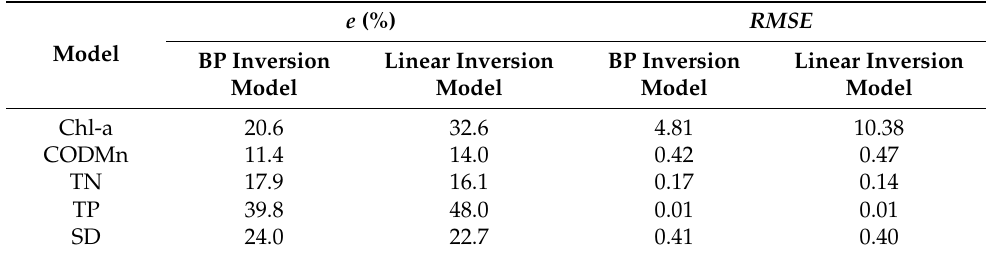
Table 6. Comparison of the evaluation index for the two kinds of inversion